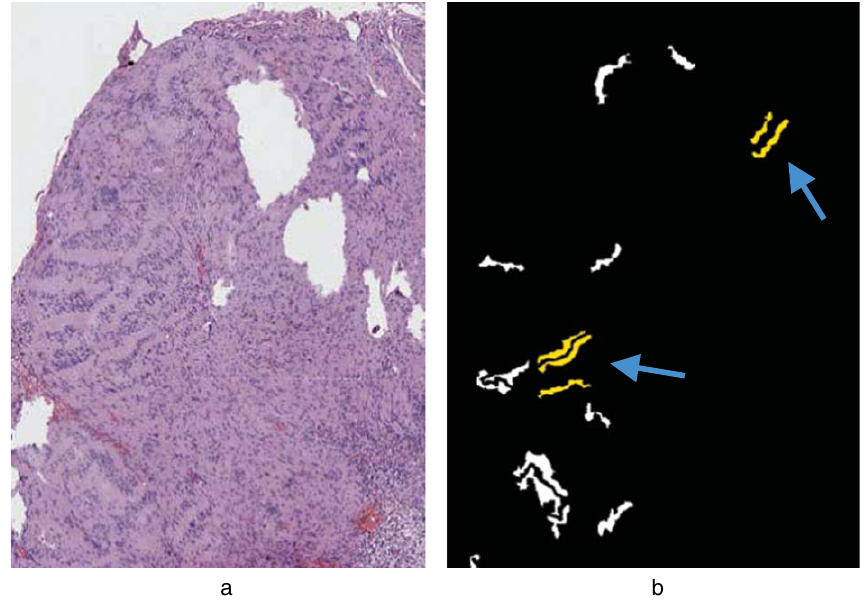
Fig. 5. Filtering palisading shapes: (a) original virtual slide, (b) detected collinear palisading areas marked by arrows.